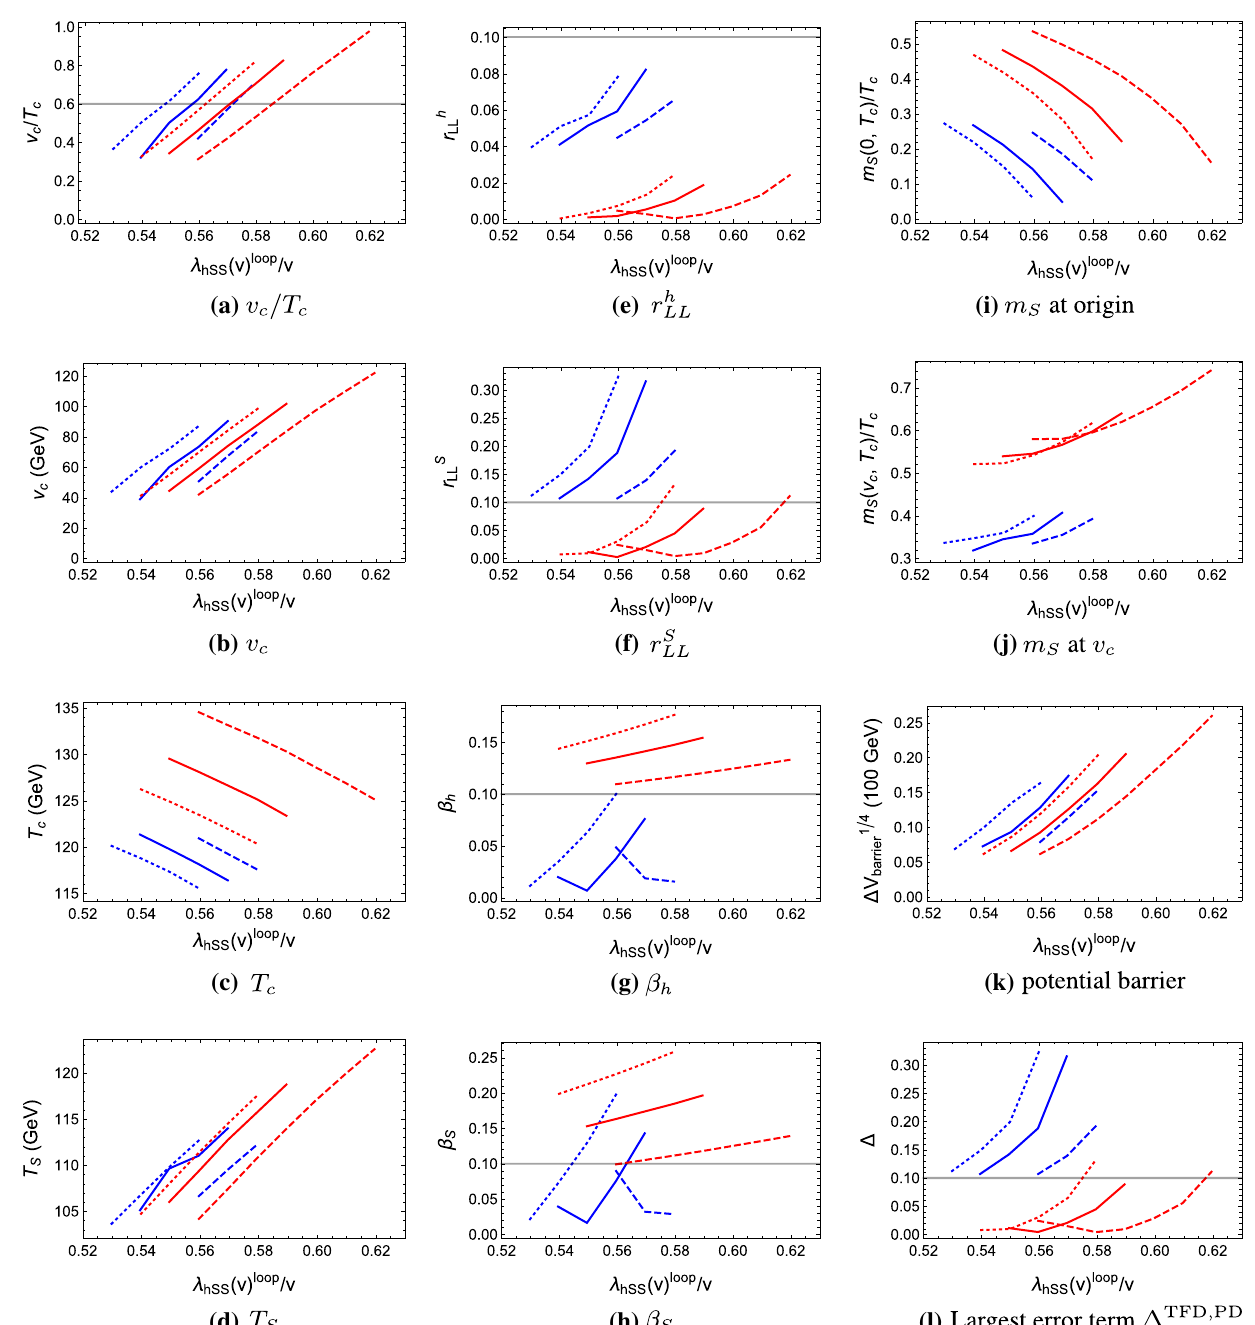
Fig. 4 Comparison of one-step phase transition in the new PD (blue) vs the standard TFD (red) calculation, for N S = 6 and ( m S ,λ loop ( 150 GeV , 1 . 0 ) . The renormalization scale is set to μ lines). Dashed (dotted) lines correspond to mu R = 2 m S ( m S / 2) to demonstrate the effect of scale variation. To the left of the curves, the